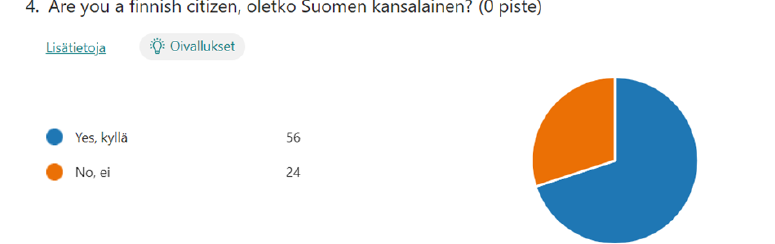
Figure 3. 70% of the respondents are Finnish citizens. Source: (Authors’ elaboration).